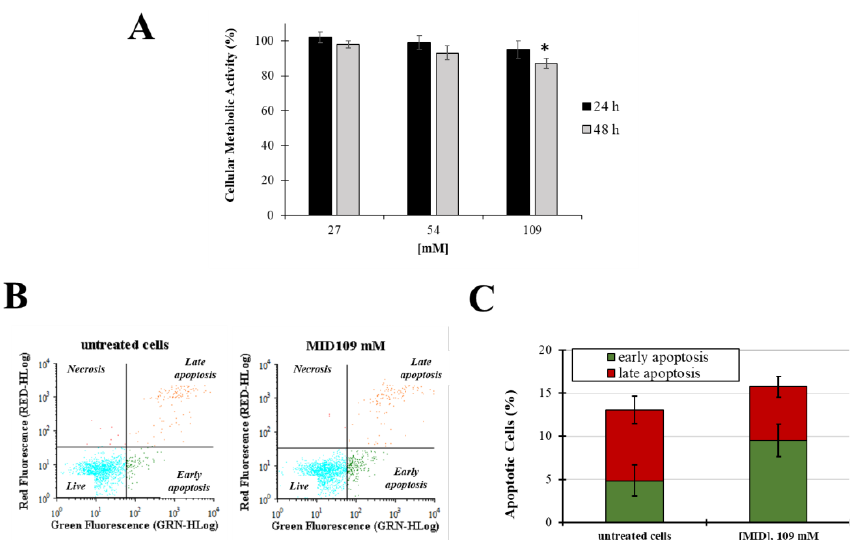
Figure 3. ( A ) Cellular metabolic activity in HTMC treated with increasing concentrations of MID for 48 h in complete culture medium (2% FCS); cell viability was determined by MTT assay. Data are expressed as the means ± S.D. of three independent experiments, each performed in triplicate. * p < 0.05 with respect to untreated control cells. ( B ) Representative flow cytogram of propidium iodide ( y -axis) vs. annexin V-FITC ( x -axis). ( C ) Histogram of the total percentage of apoptotic cells, in which values represent the means of three experiments. * p < 0.05 vs. untreated cells. Next, apoptosis and necrosis were evaluated after 48 h of treatments at the higher MID concentration (109 mM) by the annexin V-FITC/PI staining method. Fluorescence signals were monitored by flow cytometry (Figure 3B,C). No significative differences were observed in the early and late apoptosis levels ( p > 0.05) nor in the necrosis field.